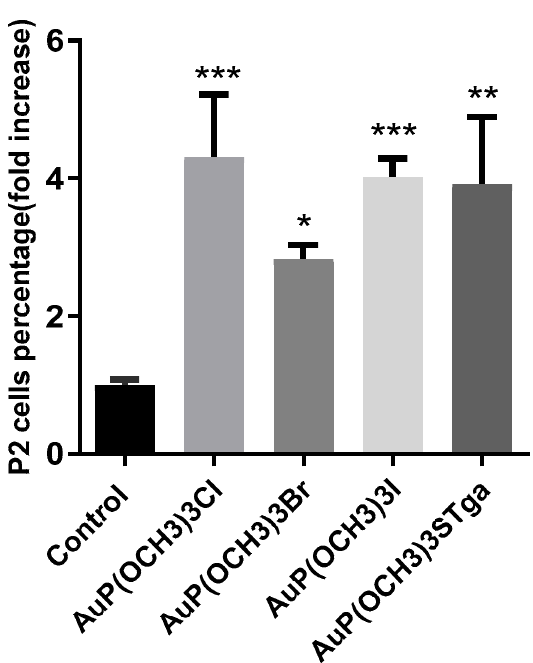
Figure 6. Caspase-3 activity shown by fluorescence-activated cell sorting analysis using FAM FLICA in A2780 cells treated for 72 h with gold compounds concentration corresponding to their 72 h exposure IC 50 -dose. Histograms report the mean values ± SD. P2 represents the percentage of the cell population with activated caspase-3 (P2 population). The statistical analysis was carried out using one-way ANOVA test followed by Tuckey’s multiple comparisons test using Graphpad Prism v 6.0 (* p < 0.05, ** p < 0.01, *** p < 0.001). All compounds cause a statistically significant activation of this caspase indicating that their cytotoxicity leads to cell death through the apoptotic